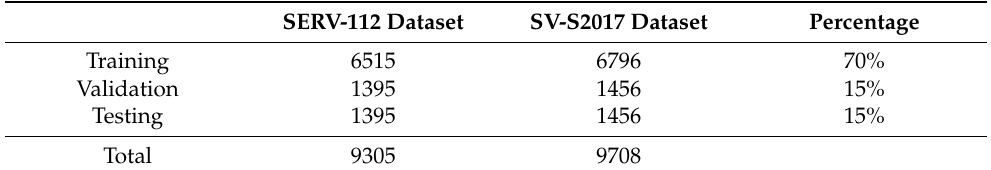
Figure 8. The Bland-Altman Plot that denotes the difference of the predicted values versus the av- Table 3. The distribution of both data sets for the training, validation, and testing datasets where 70% erage of actual diagnoses. of both datasets is used for training, 15% for validation and 15% for